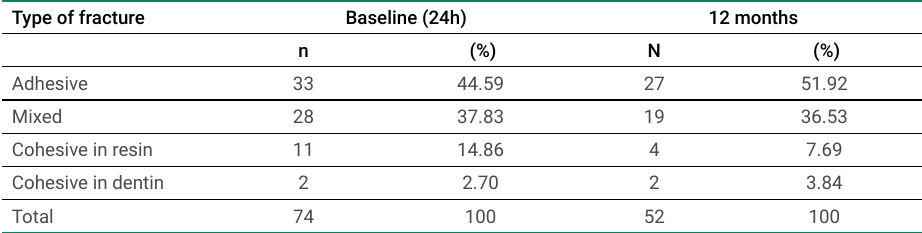
Table 3. Type of fracture in each